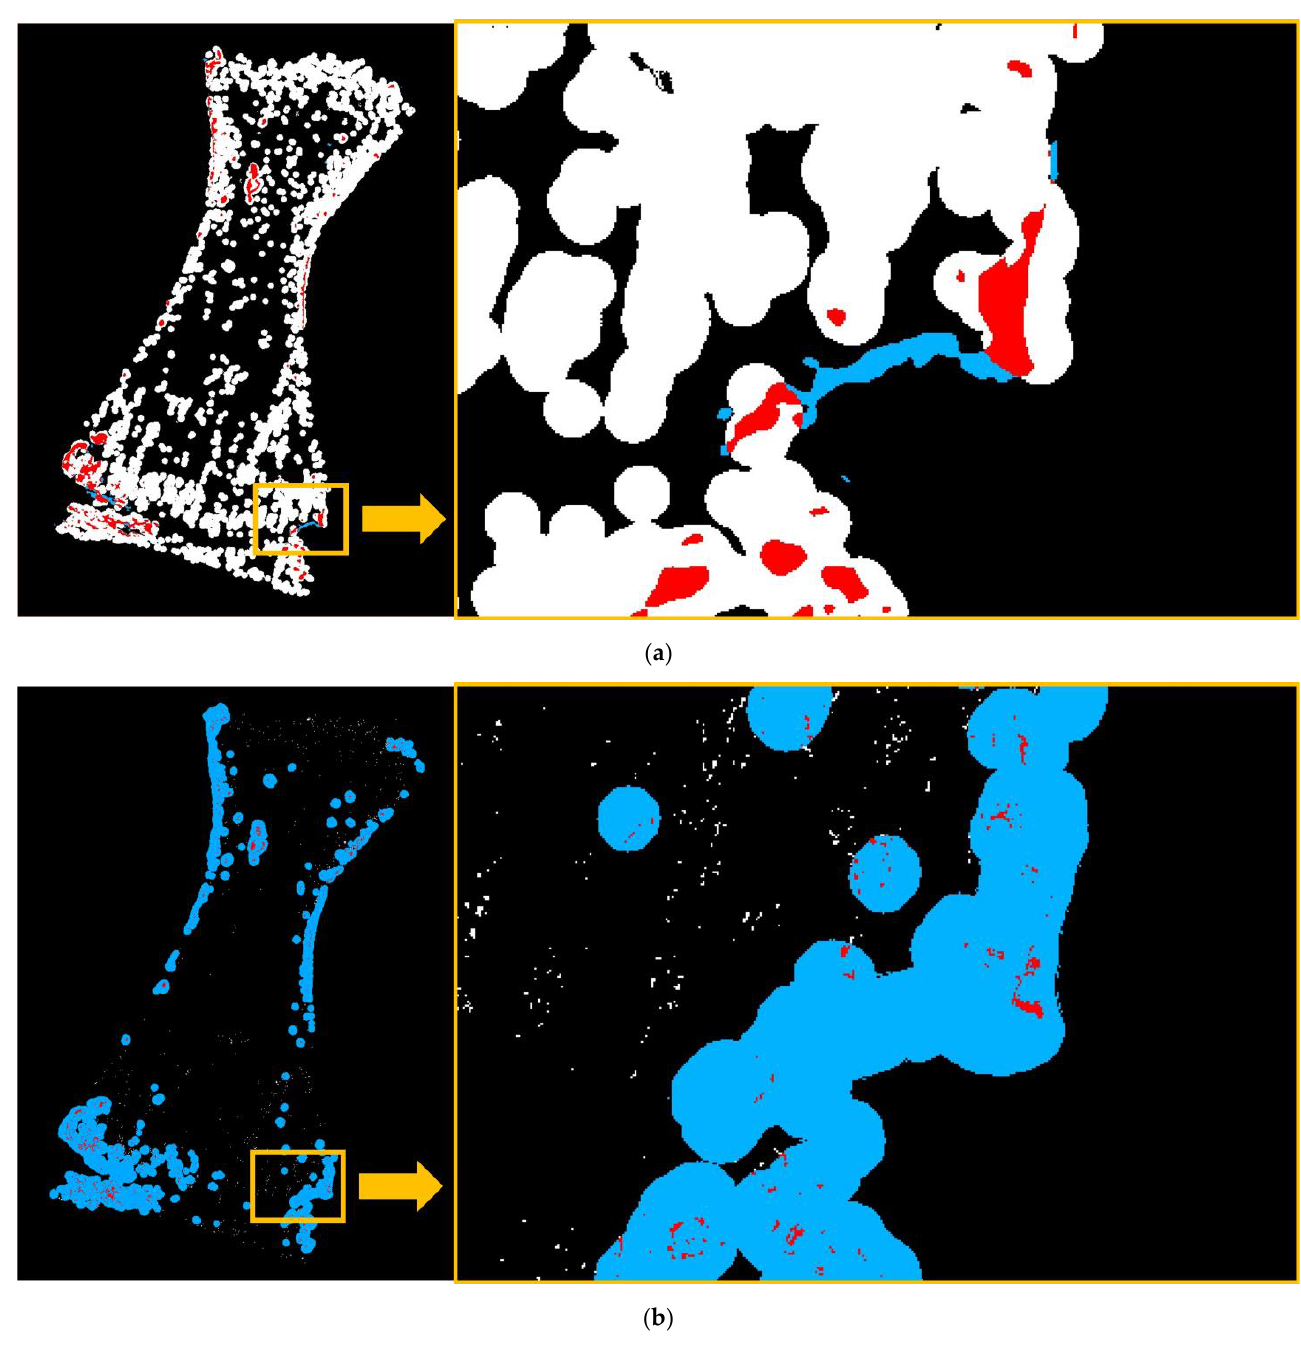
Figure 2. Label fields used to calculate spatial correlation probability of BaSO 4 -labeled pixels between BSE and enhanced µCT images at an inflation radius of 30 µm. ( a ) the probability of BaSO 4 -labeled pixels in an enhanced µCT image (blue) being within 30 µm of BaSO 4 -labeled pixels in an inflated BSE image (white). The probability of spatial correlation is calculated as the ratio of red to blue pixels. ( b ) the probability of BaSO 4 -labeled pixels in a BSE image (white) being within 30µm of BaSO 4 -labeled pixels in an inflated enhanced µCT image (blue). Red areas represent overlapping BaSO 4 -labeled pixels in both images. The probability of spatial correlation is calculated as the ratio of red to white pixels. Damage area fraction (DAF) was defined as the ratio of intersecting bone and BaSO 4 pixels to bone pixels, described in Equation (1):